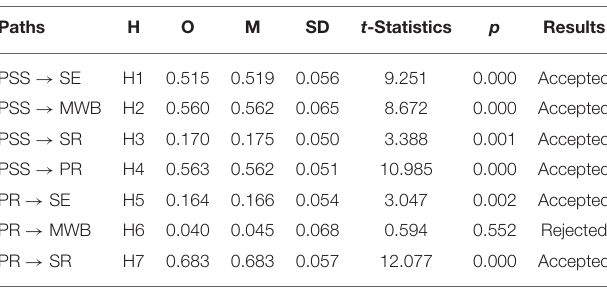
TABLE 5 | Direct effects of the